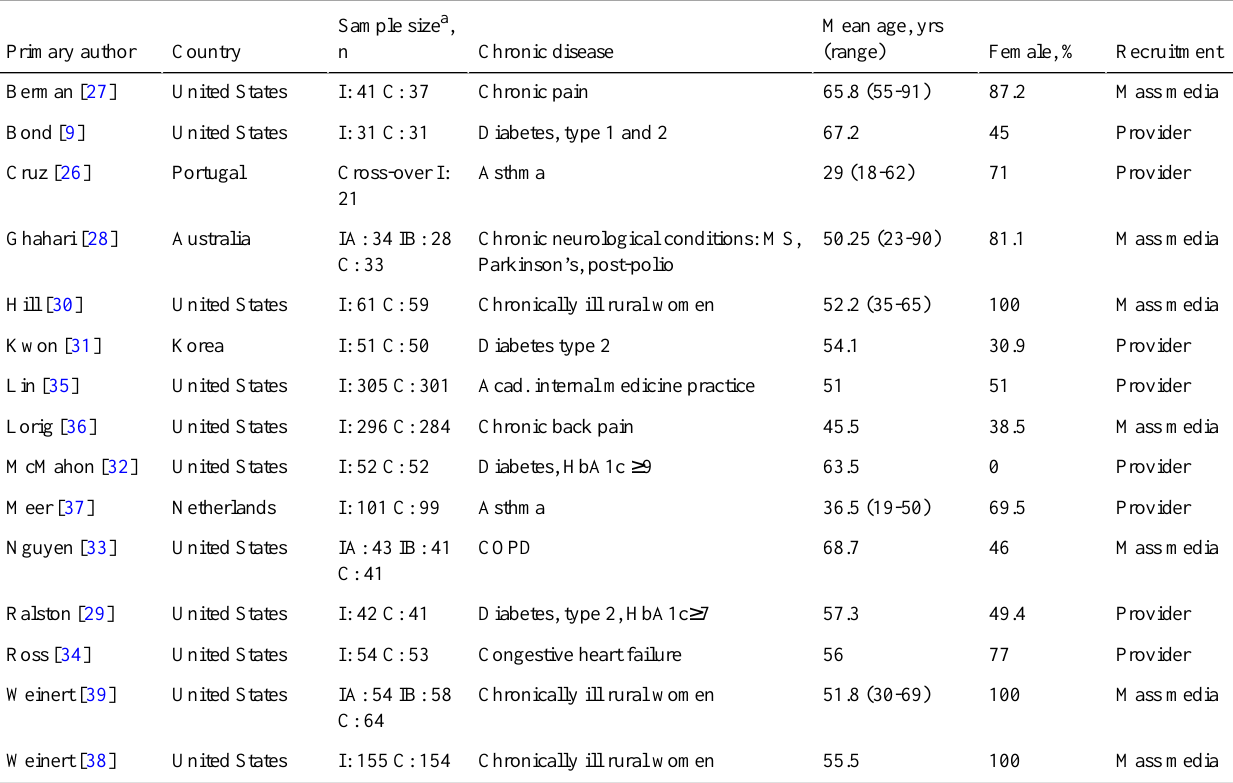
Table 1. Characteristics of the